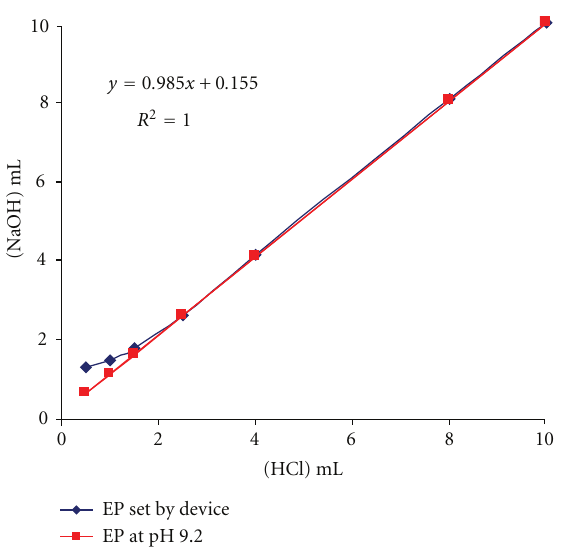
Figure 2: Titration of di ff erent amount of stearic acid in Na 2 HPO 4 and CH 3 COONa